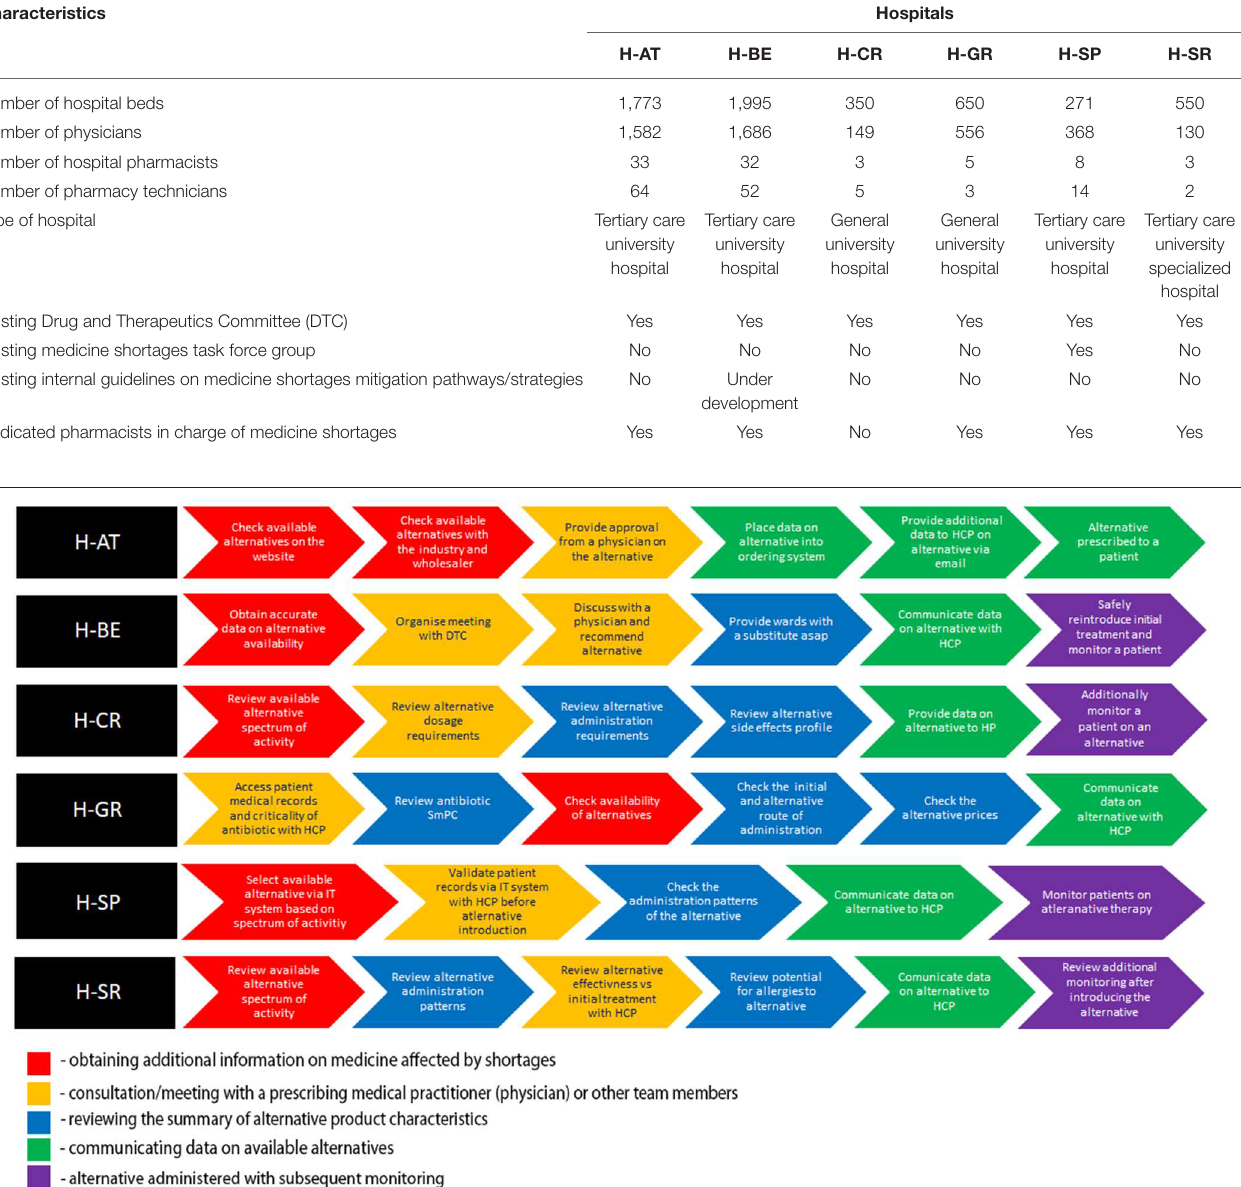
TABLE 1 | Characteristics of study hospitals.